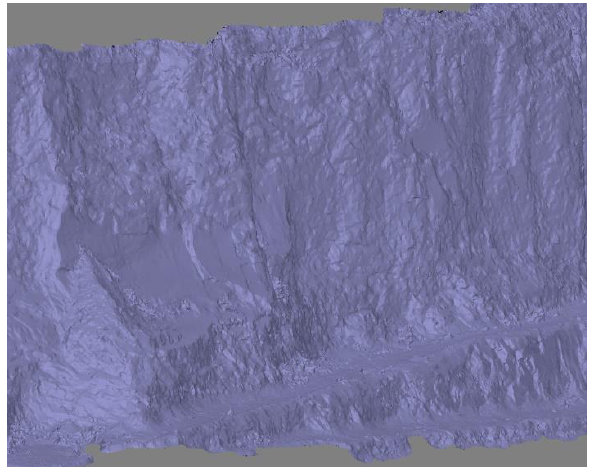
Figure 13. Part of 3D mesh of quarry’s walls.